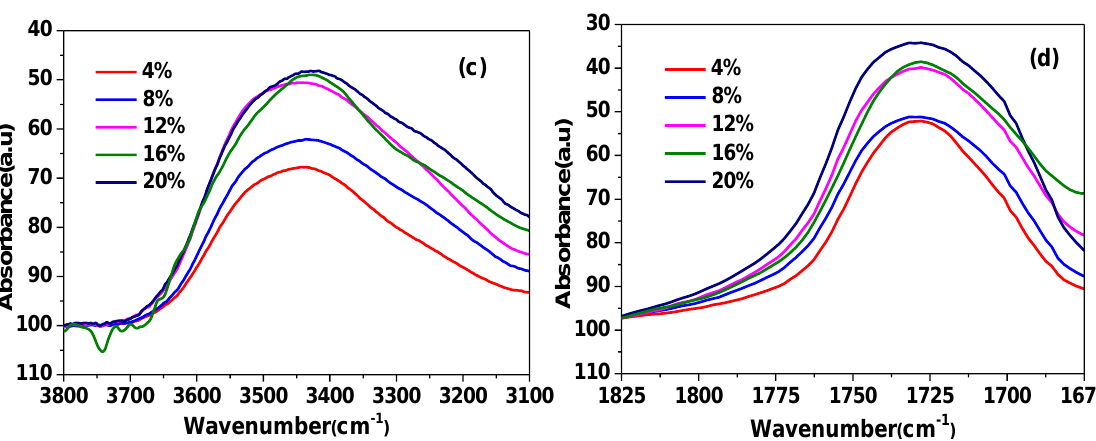
Figure 2. FTIR spectra of ( a ) BDB, FPAE, and 20% C-FPAE and ( b ) C-FPAE series with different BDB contents. ( c ) Hydroxyl and ( d ) carbonyl. Table 1. The ratio of peak intensity between 1727 and 1253 cm −1 of FPAE and C-FPAE with different BDB contents.